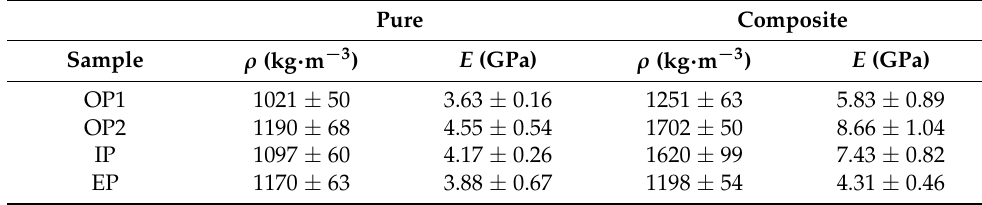
Table 4. Summary of density ( ρ ) and Young’s modulus ( E ) of the different samples.